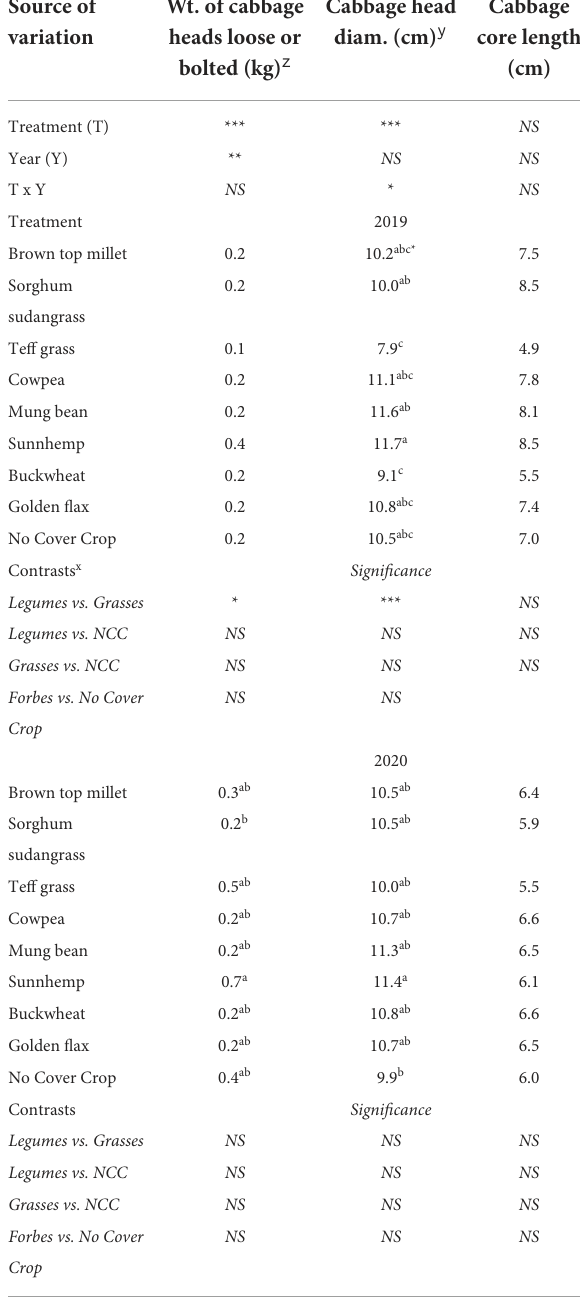
TABLE 8 Effect of cover crop treatment on loose and bolted cabbage heads (kg), mean head diameter (cm), and core length (cm). Source of